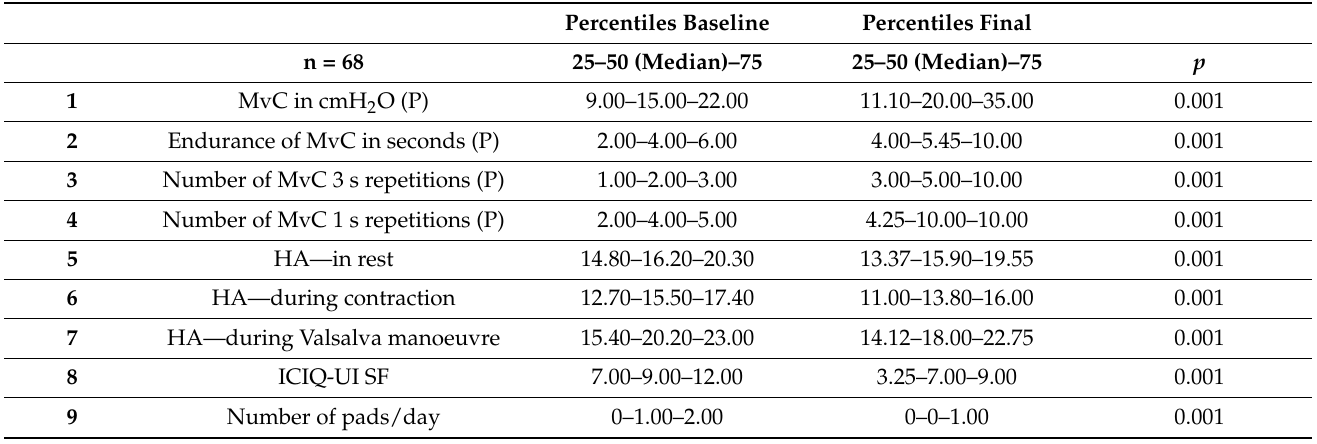
Table 2. Baseline and final percentiles of SUI symptoms, PF muscle function and morphometry and statistical differences before and after treatment (non-parametric